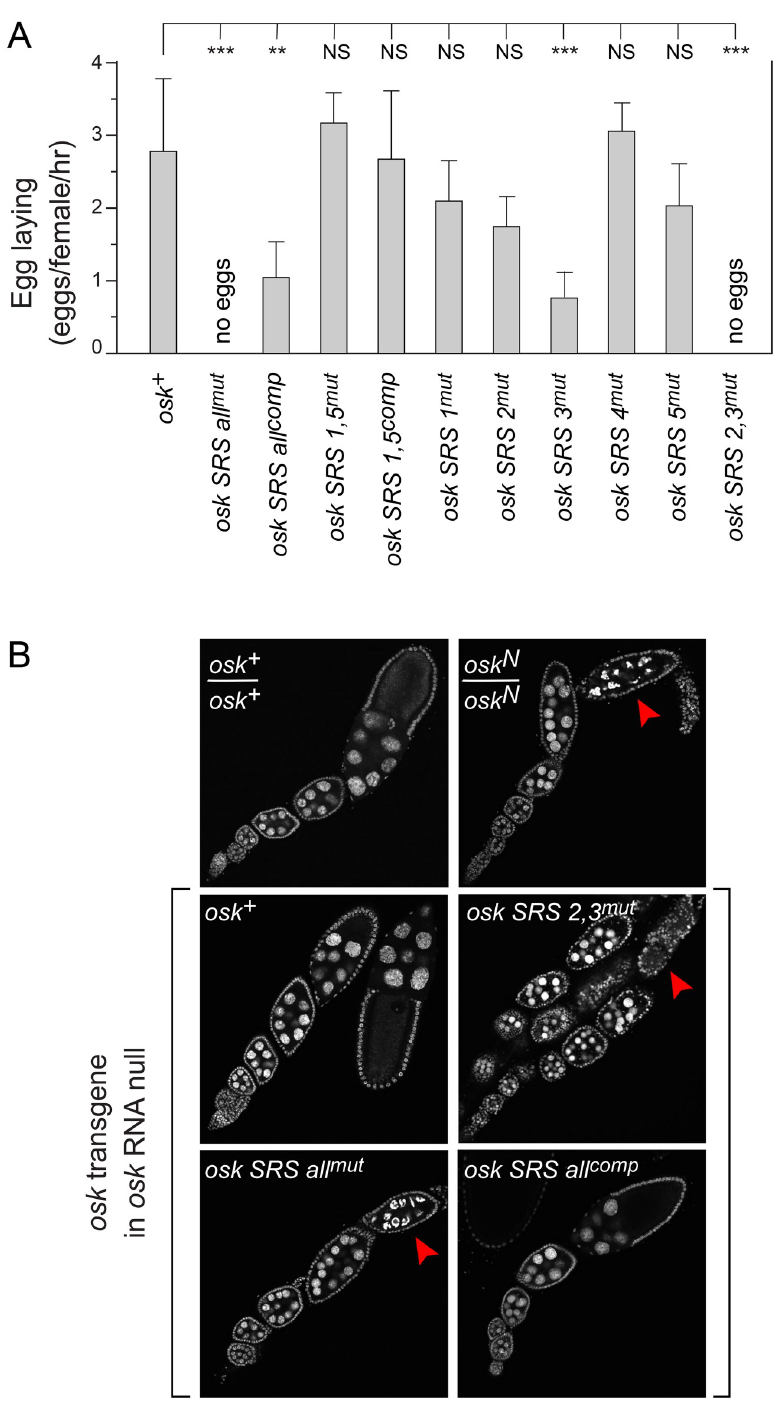
Fig 5. STAU-independent effects of SRS mutations. (A) Egg laying assays to monitor effects of SRS mutations on progression through oogenesis. Error bars show standard deviations. Statistical significance was evaluated by one-way ANOVA with F(10,38) = 19.26, P < 6 x 10 − 12 . Normality was rejected (Bonferroni corrected Shapiro-Wilk test), therefore the Wilcoxon rank sum test was used for post hoc analysis. ��� : P < 0.01, �� : P < 0.05, NS: not significant. (B) Timing of arrest of oogenesis from SRS mutations. Each panel shows one or more ovarioles from a female of the indicated genotype for osk , stained with ToPro-3 to reveal DNA (nuclei). Arrest of oogenesis results in dying egg chambers, indicated with red arrowheads. The stage of arrest from the SRS mutations was similar to that of the osk RNA null mutant, osk N . A phenotype frequently observed in osk RNA null mutant ovarioles, supernumerary nurse cells, was also found in the SRS mutants causing arrest of oogenesis. The SRS compensatory mutations, in osk SRS all comp , restore both progression through oogenesis and the correct number of nurse